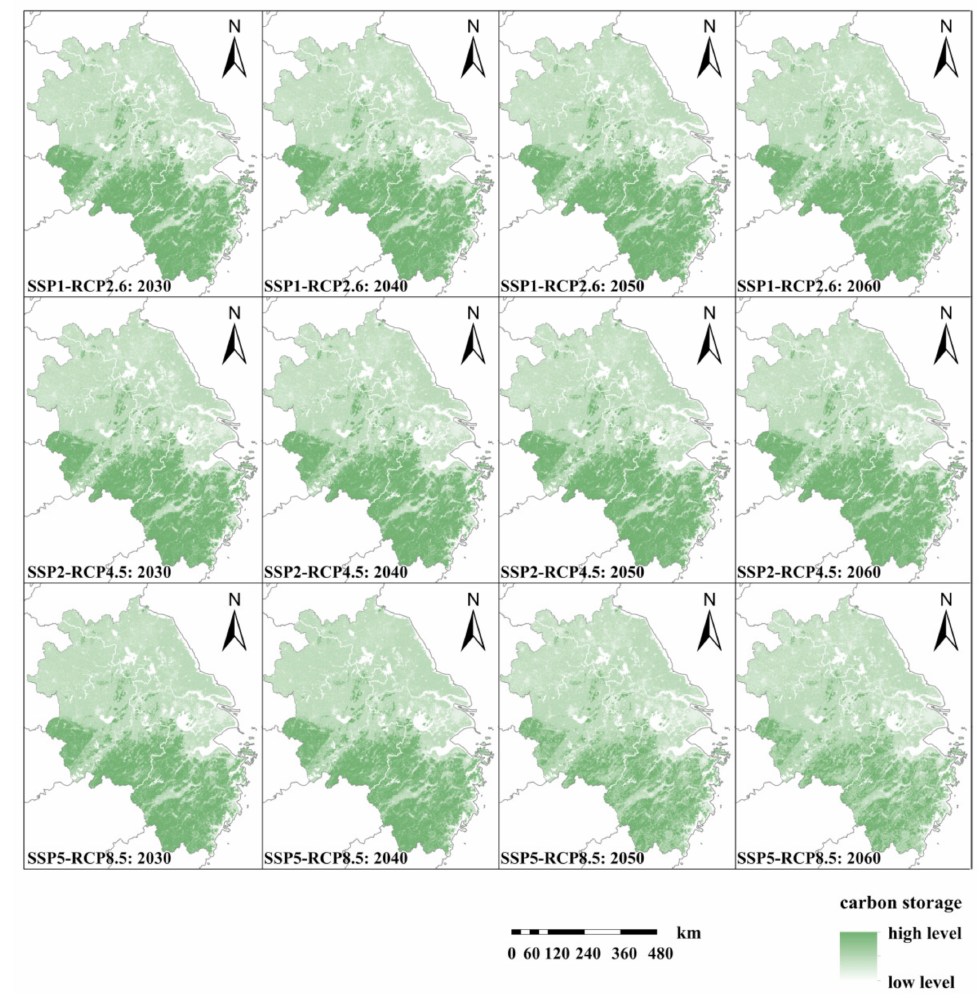
Figure 10. Carbon storage patterns under different scenarios of 2030, 2040, 2050, 2060.